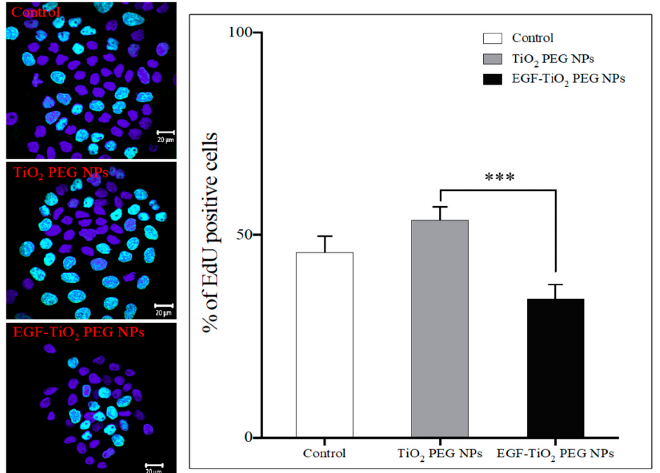
Figure 4. E ff ect of non-conjugated and EGF-conjugated TiO 2 PEG NPs on A431 DNA synthesis. Fluorescence images (left photos) show EdU incorporation into the nuclei of cells. EdU-positive cells are green and nuclei stained with 4’,6-diamidino-2-phenylindole (DAPI) are blue. Right graph shows the percentage of EdU-positive cells. Data are reported as means ± SEM for three independent experiments. Cell numbers were compared to control untreated cells (white bar). All values are presented as means ± SD ( n ≥ 6). Data were analyzed using the analysis of variance (ANOVA); *** p ≤